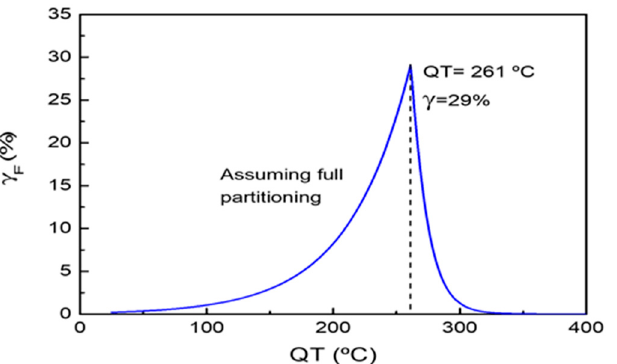
Figure 5. Estimated austenite fraction after the QP process in a full austenitization condition for the current steel. Derivation of the optimal quenching temperature.